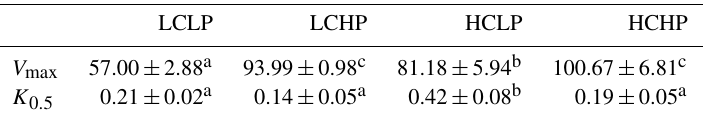
Table 2. The carbon-saturating maximum photosynthetic rate ( V max , µmolO 2 g − 1 FWh − 1 ) and half saturation constant ( K 0 . 5 , mM) for S. muticum cultured under different p CO 2 and P conditions for 13 days.